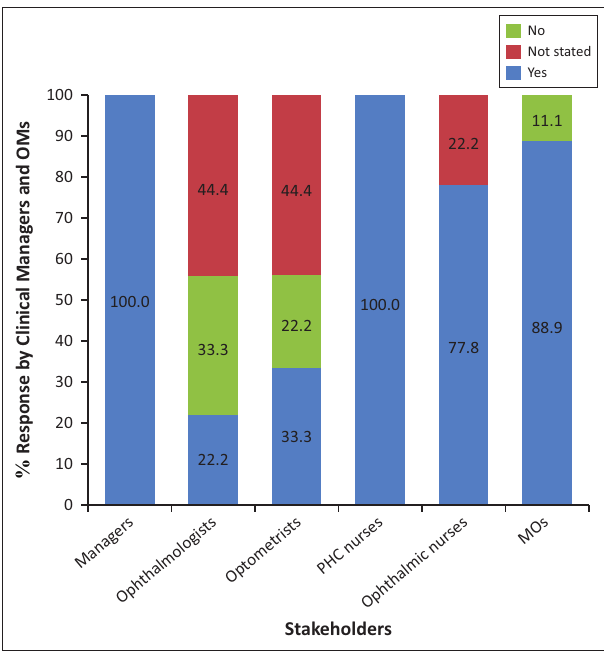
FIGURE 11: Percentage distribution for stakeholders requiring further training on diabetic eye disease management.